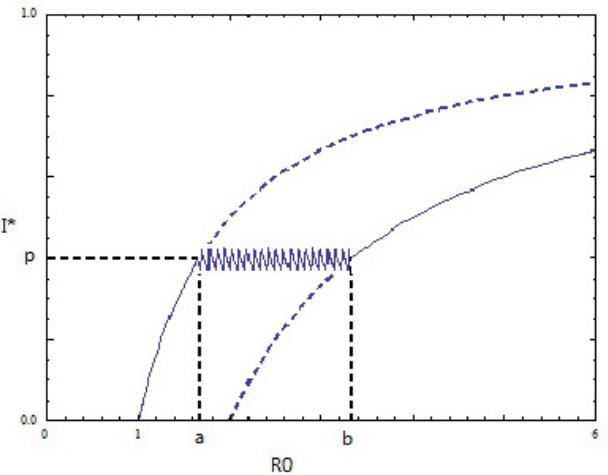
Fig. 2. The relation of I ∗ and R 0 , here a = 1 solutions are oscillating when a < R 0 < b